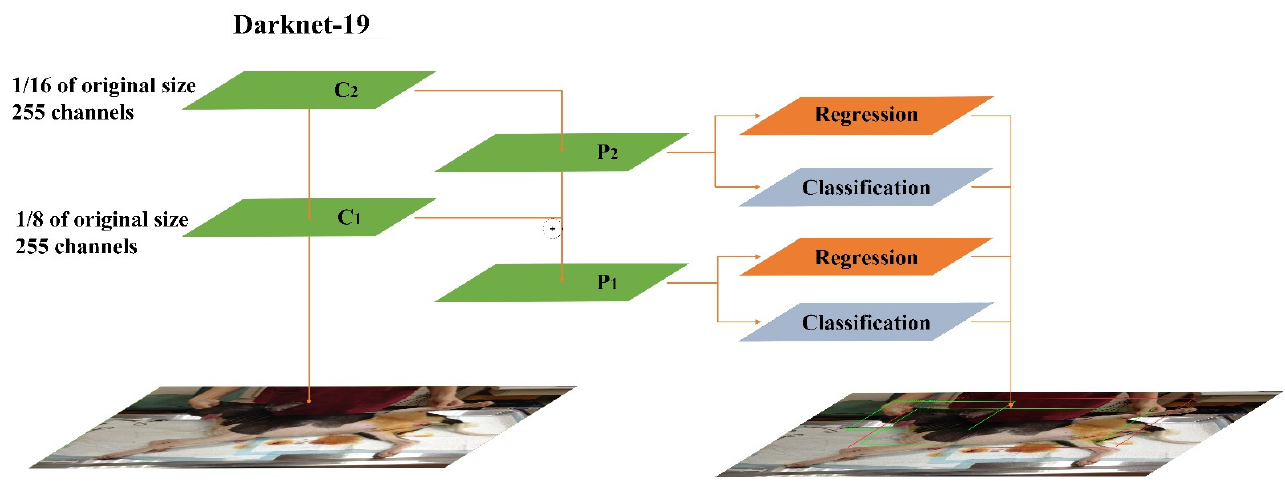
Figure 2. Structure of YOLOv3-Tiny [26] C1,C2 refer to the feature layers of the last two scale. P1,P2 (After superimposition of adjacent layers through upper sampling). ⊕ refers (The superimposition operation).